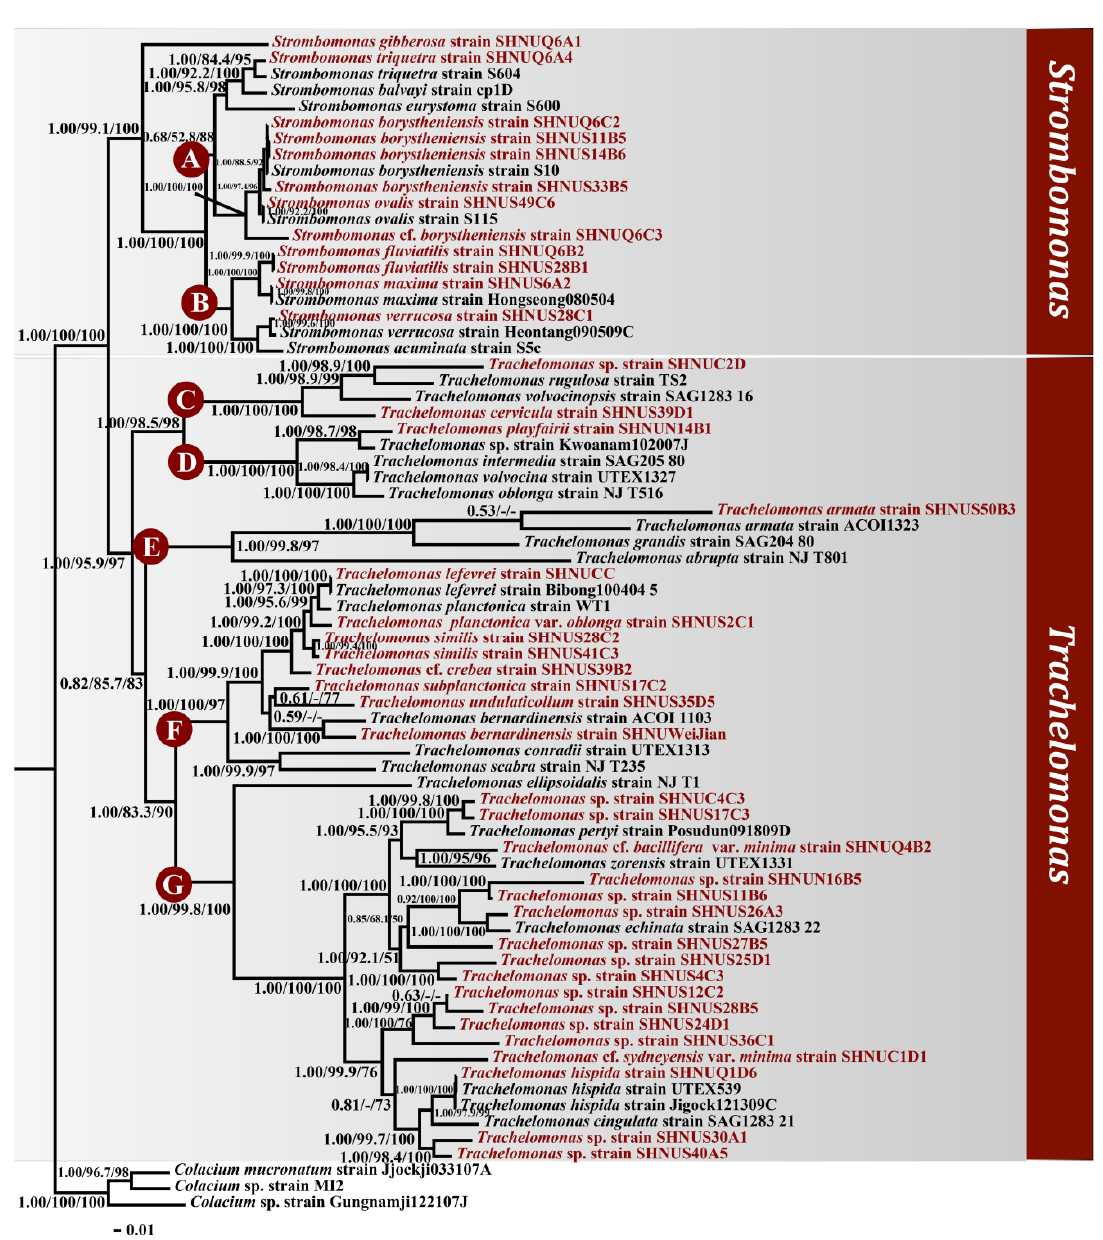
Figure 5. Bayesian phylogenetic tree based on combined nuclear SSU, nuclear LSU plastid SSU and plastid LSU rDNA sequences. Support values for all analyses are shown on branches as follows: Bayesian posterior probabilities (BA)/SH aLRT values/maximum likelihood bootstrap values (ML). The pp values < 0.50, SH aLRT values < 50 or rbs values < 50 was marked with a hyphen (-). Strain collected from China in red.